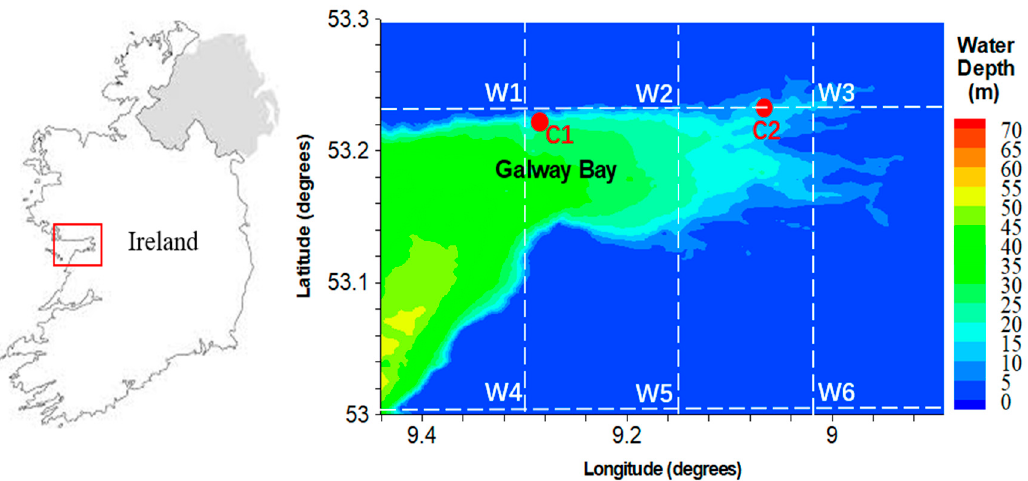
Figure 1. Deployment of the high frequency radar (HFR) system (C1 and C2 indicate deployment location of HFR station).